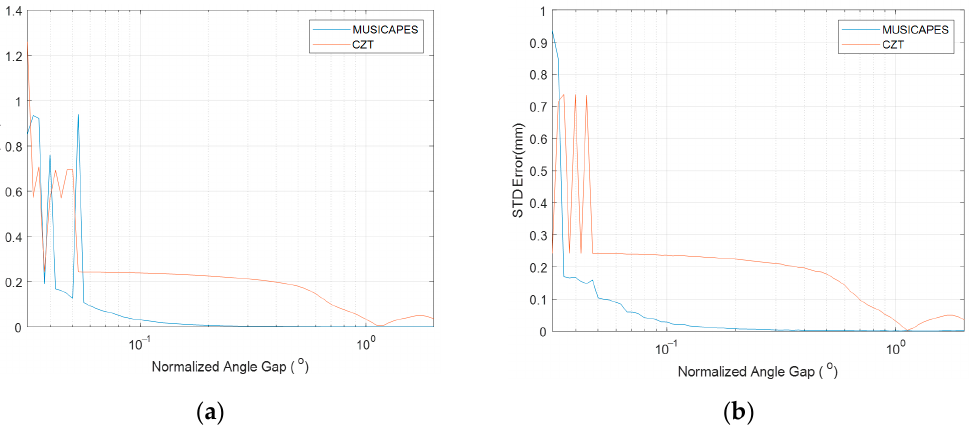
Figure 8. STD of displacement difference vs. angle interval. ( a ) STD of ‘Target1’; ( b ) STD of ‘Target2’.